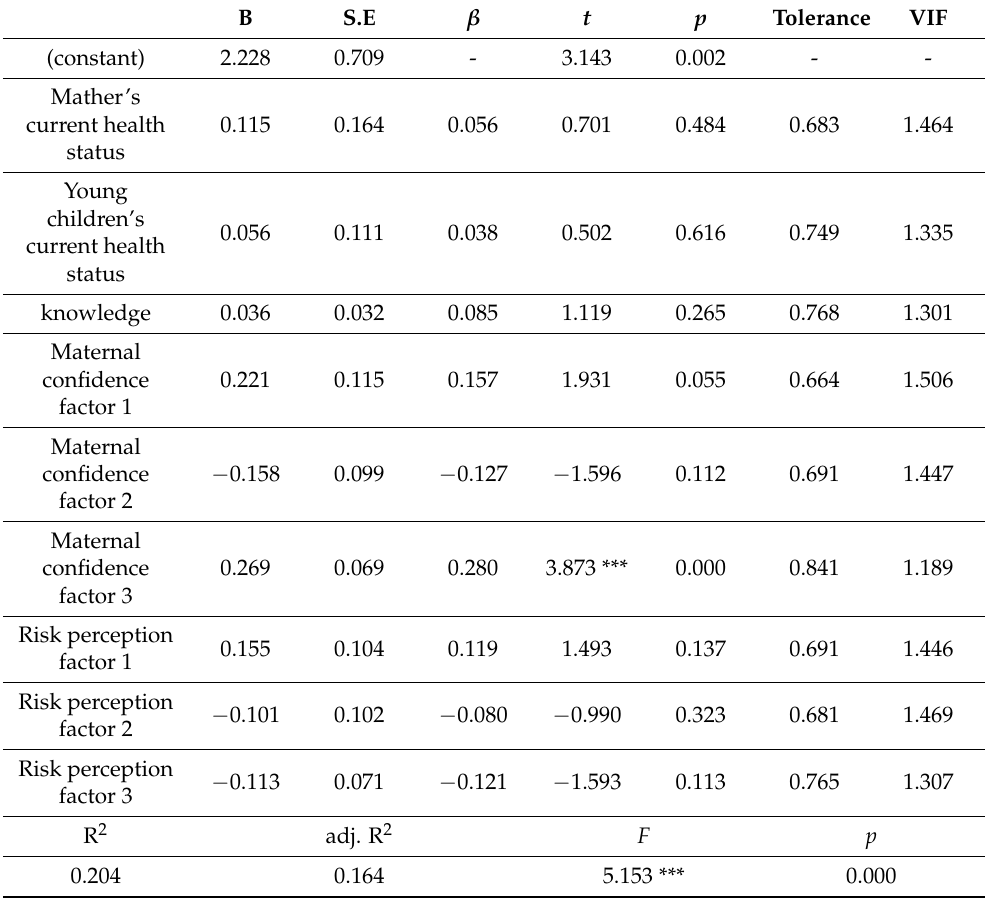
Table 3. Effect of knowledge, maternal confidence, and risk perception on Preventive health behaviors of COVID-19 factor